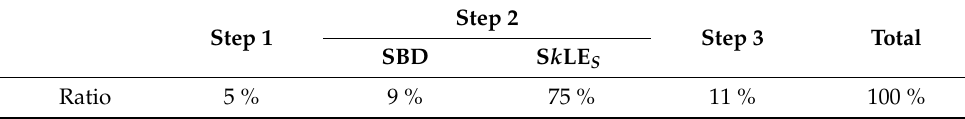
Table 5. Running time ratio by steps in our P k NC